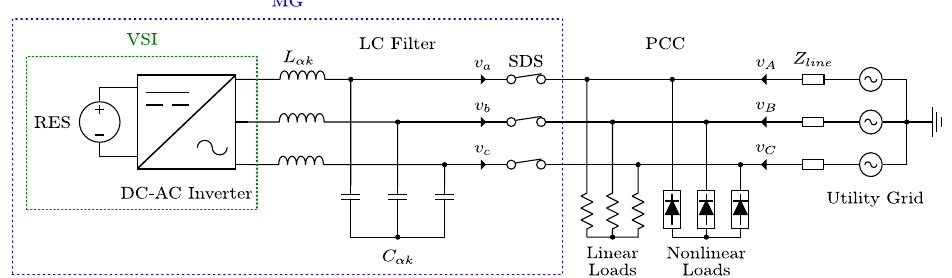
Figure 2. MG structure used in this work compounding by LC filter and